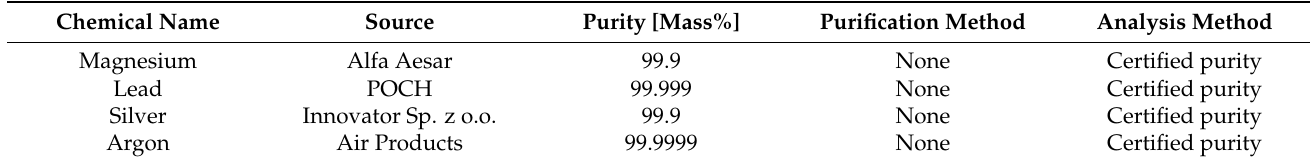
Table 1. Specifications of the applied